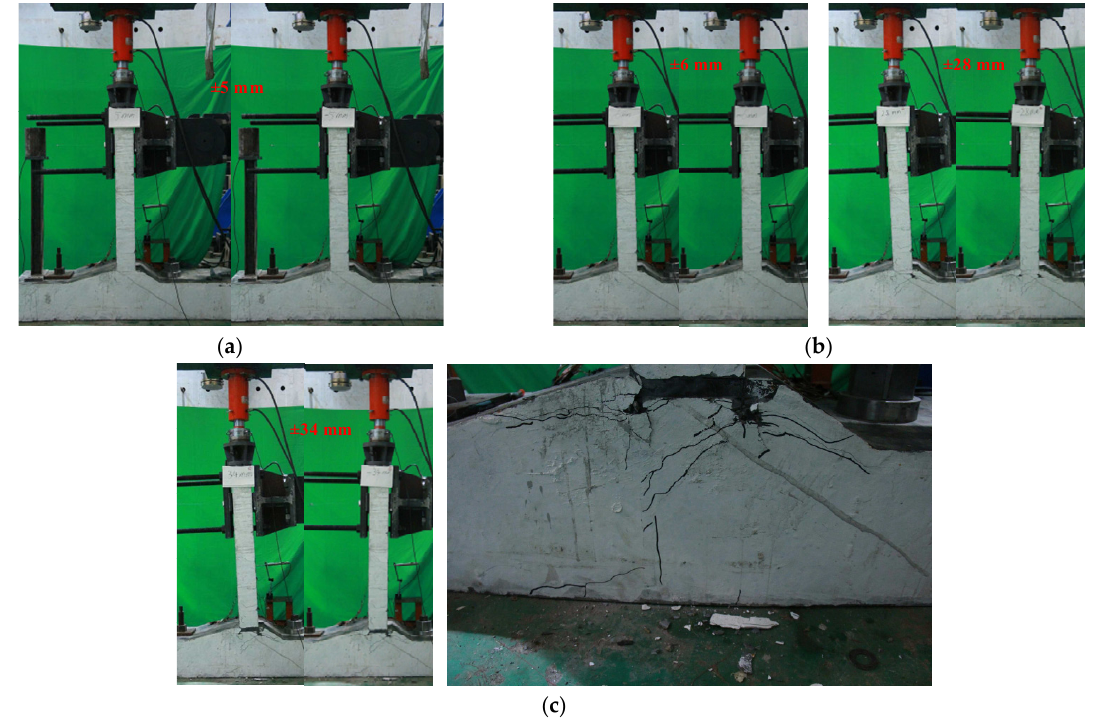
Figure 10. Test phenomenon of the T-shaped specimen. ( a ) Uncracked stage (5 mm); ( b ) cracking stage (6 to 28 mm); ( c ) damage phase (34 mm).